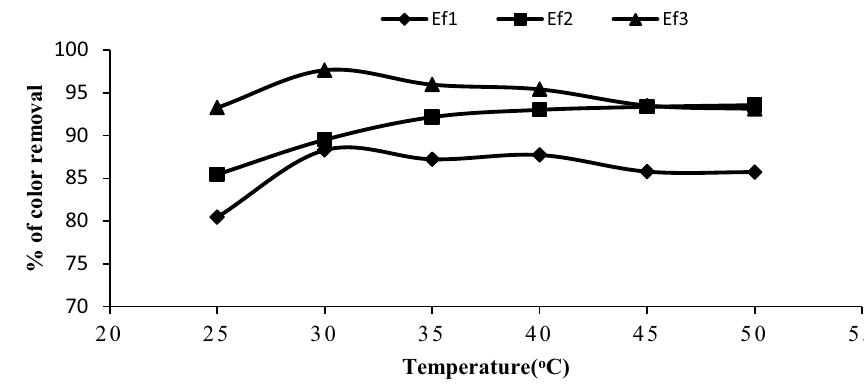
Fig. 5 Effect of temperature on the color removal efficiency of the coagulant from the textile dyeing effluents (pH = 7.65, 6.70 and 8.10 of the Ef1, Ef2 and Ef3, respectively, coagulant dose 300 mg/L and agitation speed 60 rpm for PAC coagu- lant)